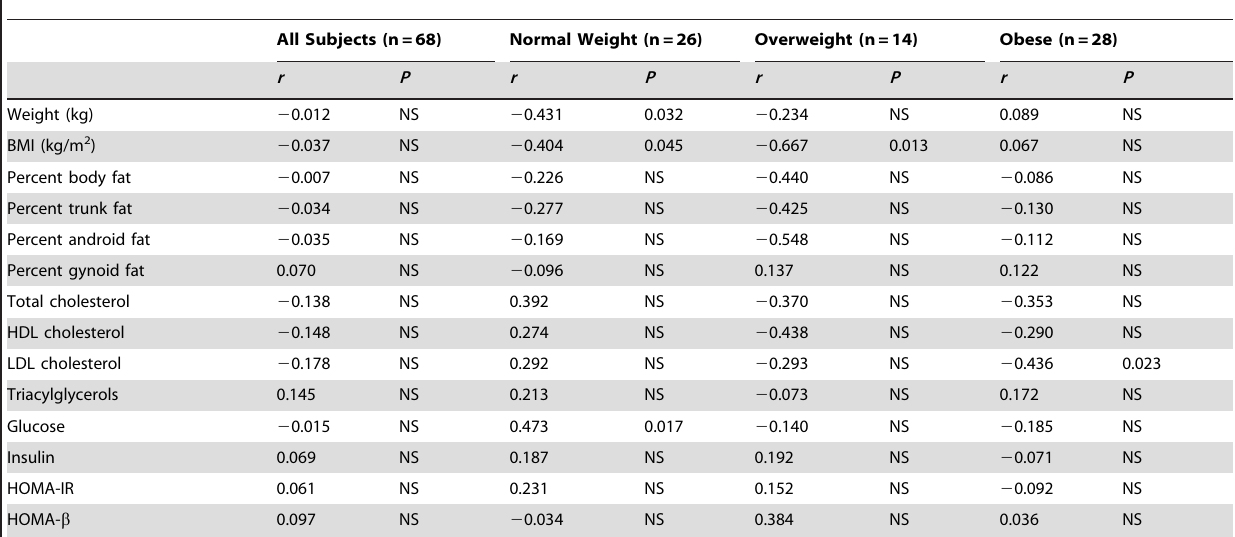
Table 2. Partial correlations of baseline variables related to baseline fasting serum ghrelin concentration a,b .